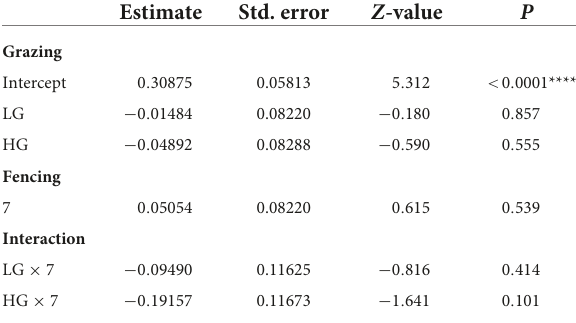
TABLE 4 Results of generalized linear mixed models (GLMMs) for species Shannon diversity of insects sampled after 3 or 7 fencing years in three grazing treatments in a desert steppe: Ungrazed plot (CK, used as reference), light grazed (LG), and heavily grazed (HG). Estimate Std.